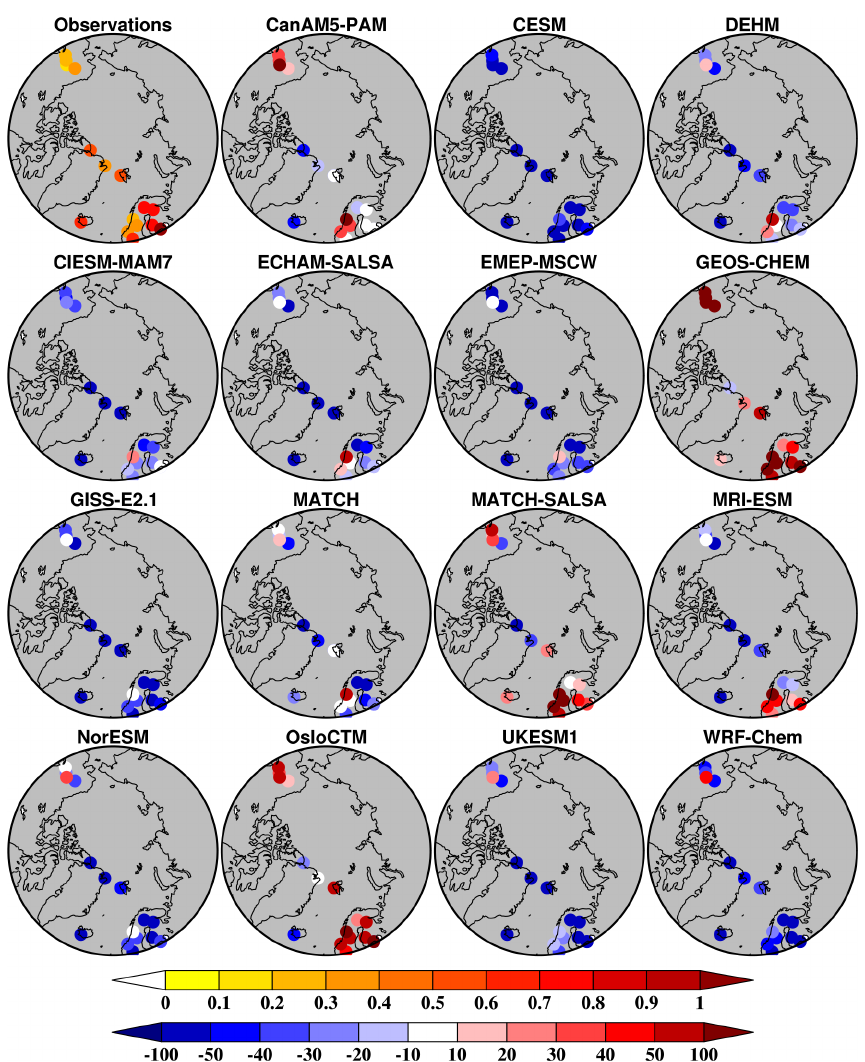
− concentrations (µg m − 3 , top color bar) at surface Arctic measurement sites and model bias (as model– Figure 18. Mean measured SO 2 4 measurement / measurement in percent, bottom color bar) for 2014–2015. Results from 2008–2009 are similar and not